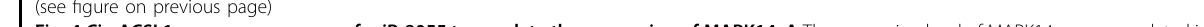
Fig. 4 CircACSL1 serves as a sponge of miR-8055 to regulate the expression of MAPK14. A The expression level of MAPK14 was upregulated in MC patient samples and LPS-induced HCM in fl ammatory model as estimated by qRT-PCR and WB. B The expression level of miR-8055 was downregulated in MC patient samples and HCM in fl ammatory model as detected by qRT-PCR. C After transfection with sh-circACSL1 or circACSL1 overexpression vector, the miR-8055 expression was measured by qRT-PCR. D The mRNA level of MAPK14 in HCM with overexpression or knockdown of circACSL1. E The mRNA level of MAPK14 in HCM with miR-8055 overexpression or knockdown. F The protein level of MAPK14 in HCM with overexpression or knockdown of circACSL1. G The protein level of MAPK14 in HCM with miR-8055 overexpression or knockdown. H , I The higher expression of MAPK14 in HCM with circACSL1 overexpression could be rescued by miR-8055 overexpression, and sh-miR-8055 could relieve the inhibition of sh-circACSL1 on MAPK14 expression. J , K The expression of miR-8055 and MAPK14 could not be affected by mutant circACSL1. L1 miR- 8055 was pulled down by the biotin-circACSL1 probe, detected by qRT-PCR. L2 circACSL1 was pulled down by the biotin-miR-8055 probe, detected by qRT-PCR. The relative level was normalized to input. M RNA-FISH revealed the cytosolic colocalization of circACSL1 and miR-8055 in HCM. CircACSL1 probes were labeled with CY3 (red). miR-8055 probes were labeled with FAM (green). Nuclei were stained with DAPI (blue). Scale bar, 50 µm. N1 The complementary binding sites in wild-type (WT) and mutant sites (Mut) 3 ′ -UTR of MAPK14 and circACSL1 for miR-8055 targeting. N2 Luciferase reporter assay veri fi ed the molecular interactions of miR-8055 with the 3 ′ -UTR of MAPK14 and circACSL1 wild-type transcripts. Data are presented as mean ±SD ( n = 3 biologically independent samples). * p < 0.05; ** p < 0.01; *** p < 0.001 (Student ’ s t